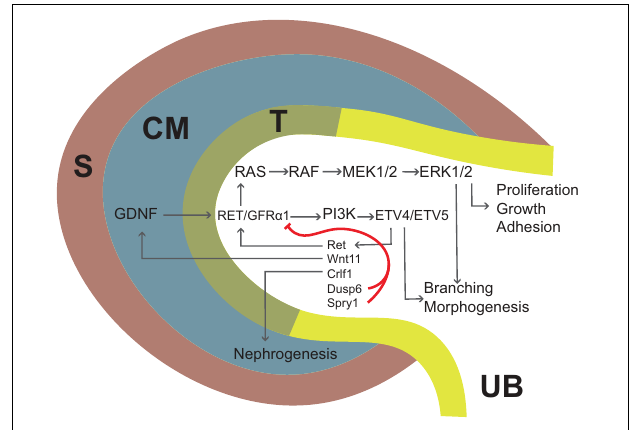
FIGURE 4 | Schematic depiction of GDNF/RET/GFR α 1 signaling in the ureteric bud (UB) tip during kidney development. Gdnf is first expressed in the CM (dark blue) and later also in the surrounding stroma (S, brown). GDNF binds to RET/GRF α 1 complex in the UB tip (T, olive green), initiating downstream cascades such as the MAPK and PI3K pathways. Several factors are transcriptionally activated downstream of RET signaling and include Ret itself; Wnt11, which upregulates GDNF; Crlf1, which induces nephrogenesis; and Dusp6 and Spry1, which inhibit RET/GFR α 1. ETV4 and -5 are transcription factors mediating the GDNF/RET response to UB epithelium and their expression depends on PI3K signaling. Signaling via the MAPK pathway is important for proliferation, growth, and adhesion, and plays a major role in branching morphogenesis (Moore et al., 1996).